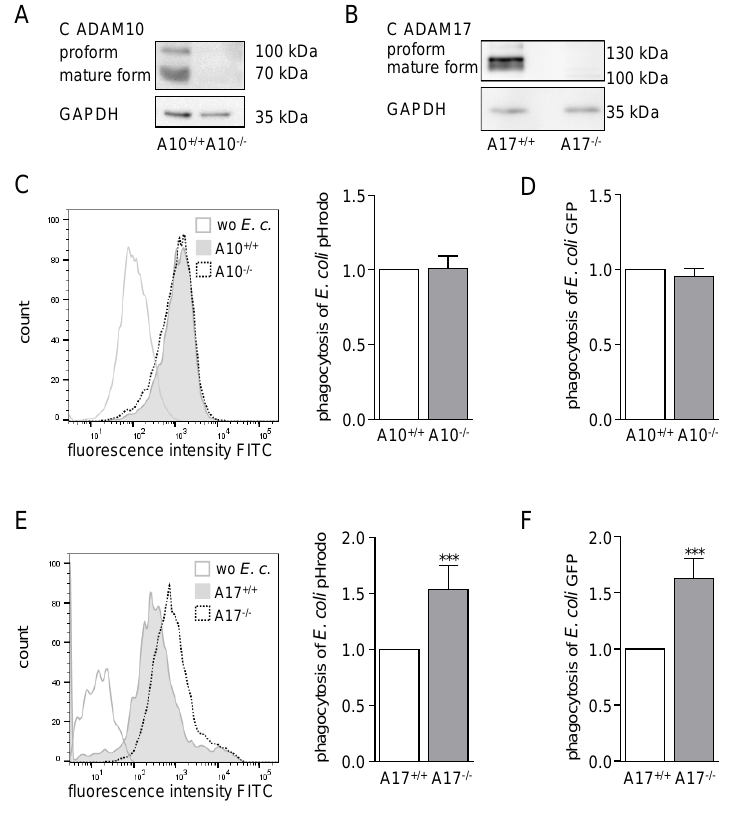
Figure 2. Deficiency of ADAM17 in BMDMs leads to increased phagocytosis of E. coli. ( A , B ) BMDMs from Vav- Adam10 − / − mice (A10 − / − ) ( A ) or Vav- Adam17 − / − mice (A17 − / − ) ( B ) and their respective